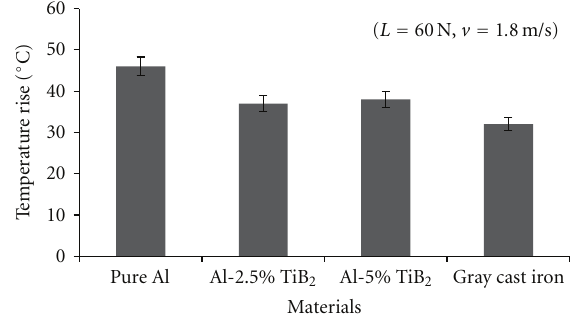
Figure 10: Temperature rise variation of sliding pins made out of di ff erent